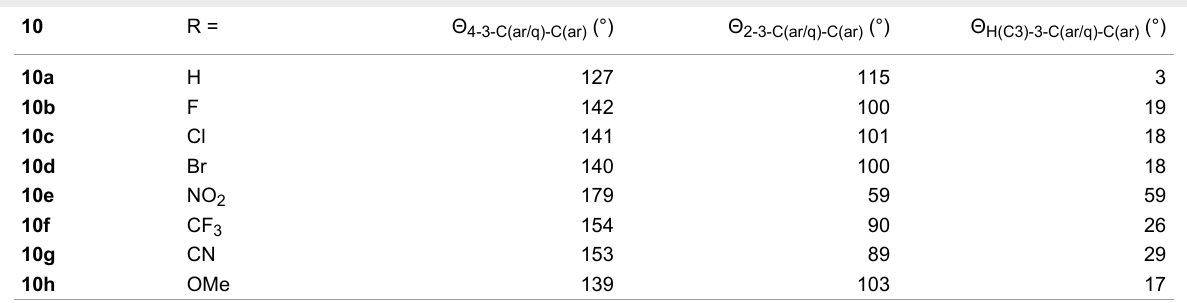
Table 2: Structural features of the 1,2,4-trioxanes 10a – h . a